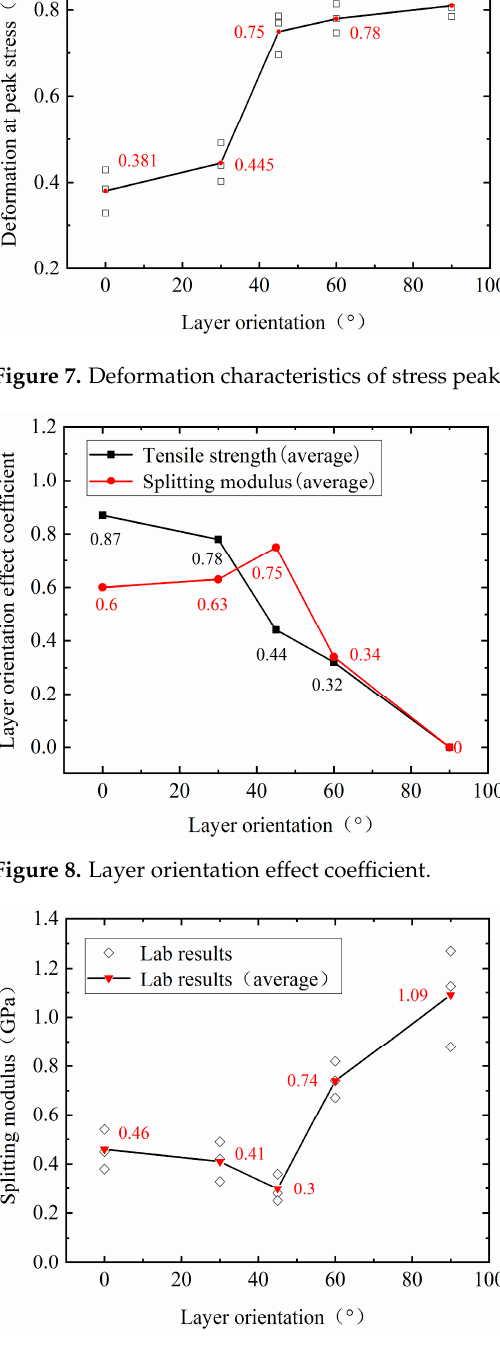
Figure 9. Splitting modulus of samples with different layer orientations.